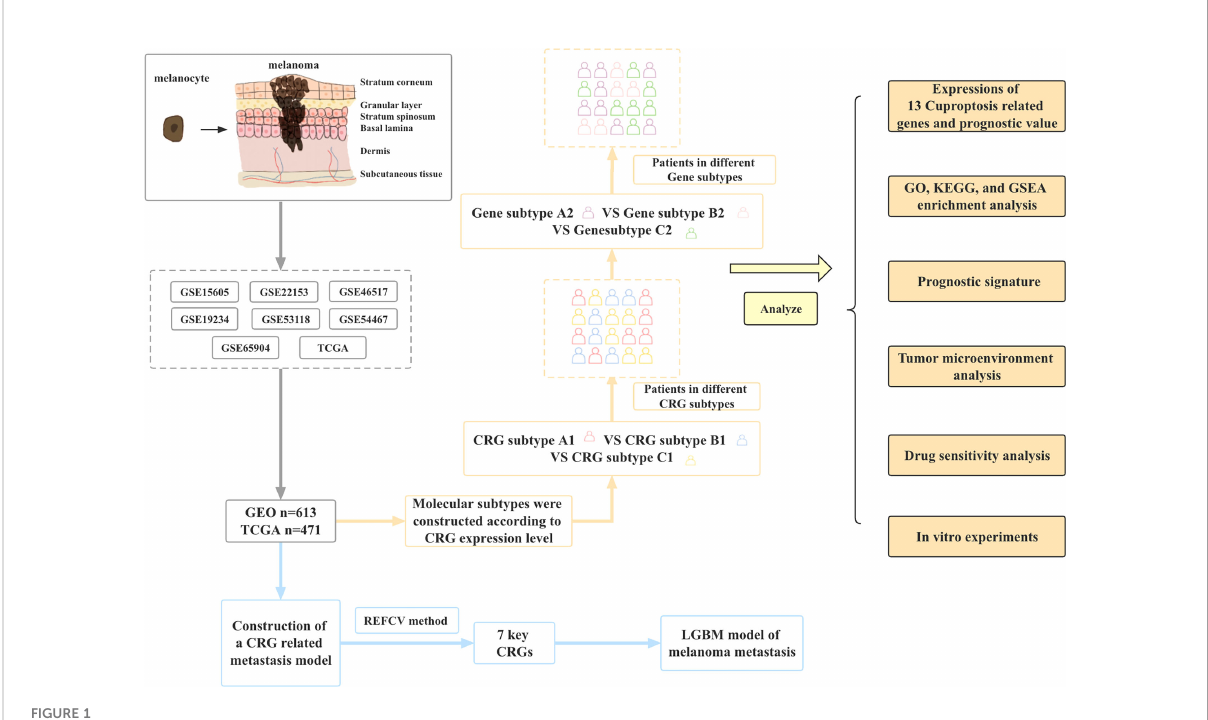
FIGURE 1 Article framework and work fl